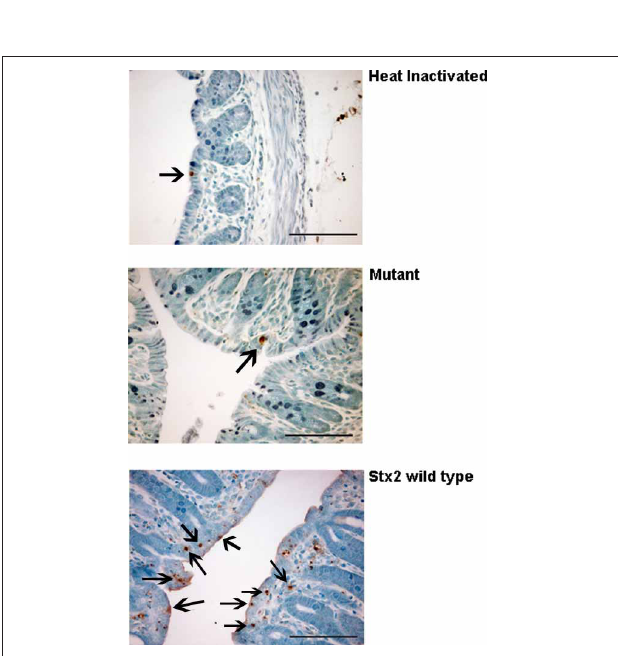
tissue was scored for edema and congestion/hemorrhage for tissue samples from four of the five litters (HI, n = 6; Mut, n = 10; Stx2 n = 8). ∗ Significance ( P -value < 0.05) was determined by one-way ANOVA.